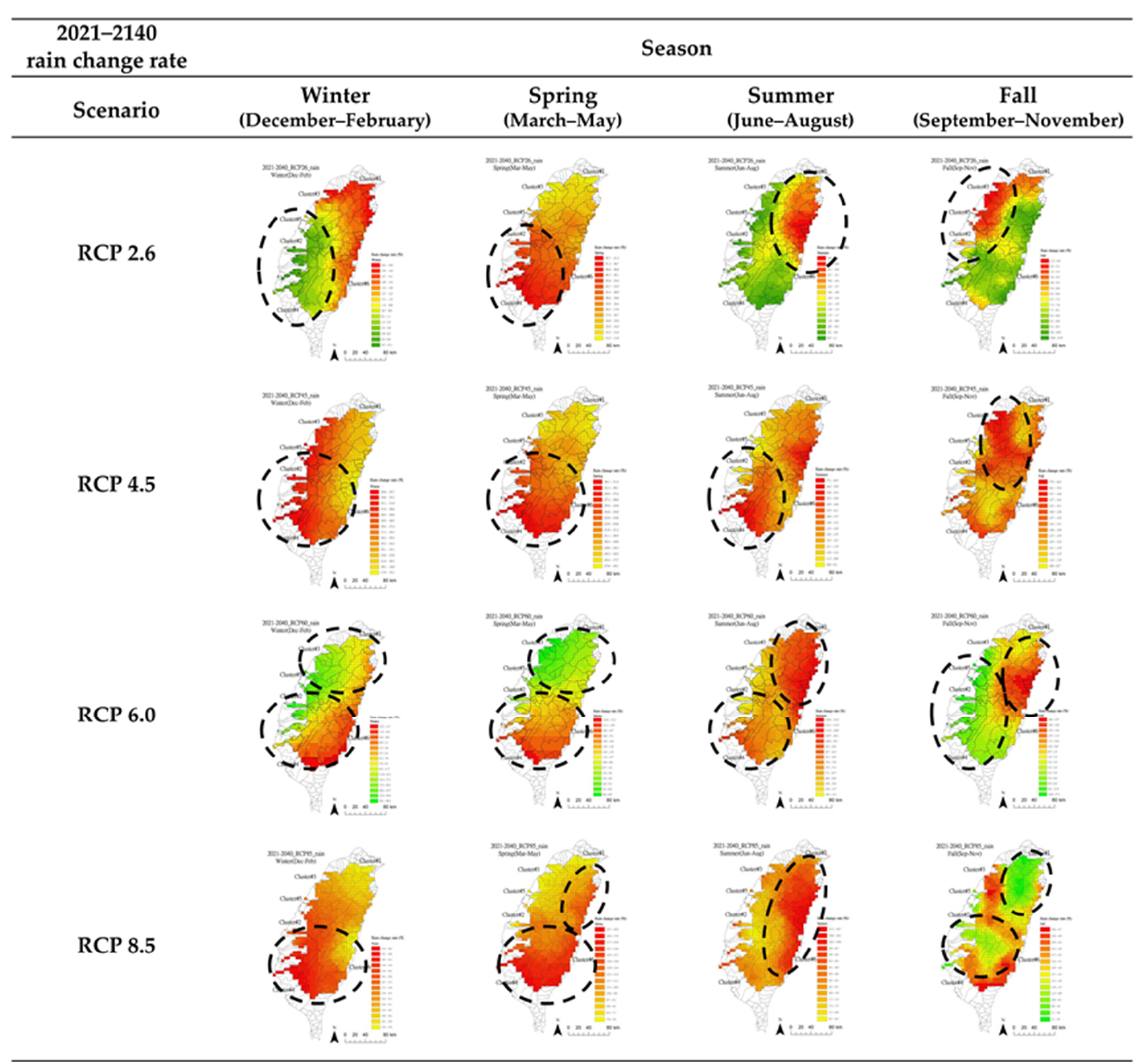
Figure A5. Spatial distribution of rain change rate from 2021–2040 for four seasons under different climate change scenar- ios.